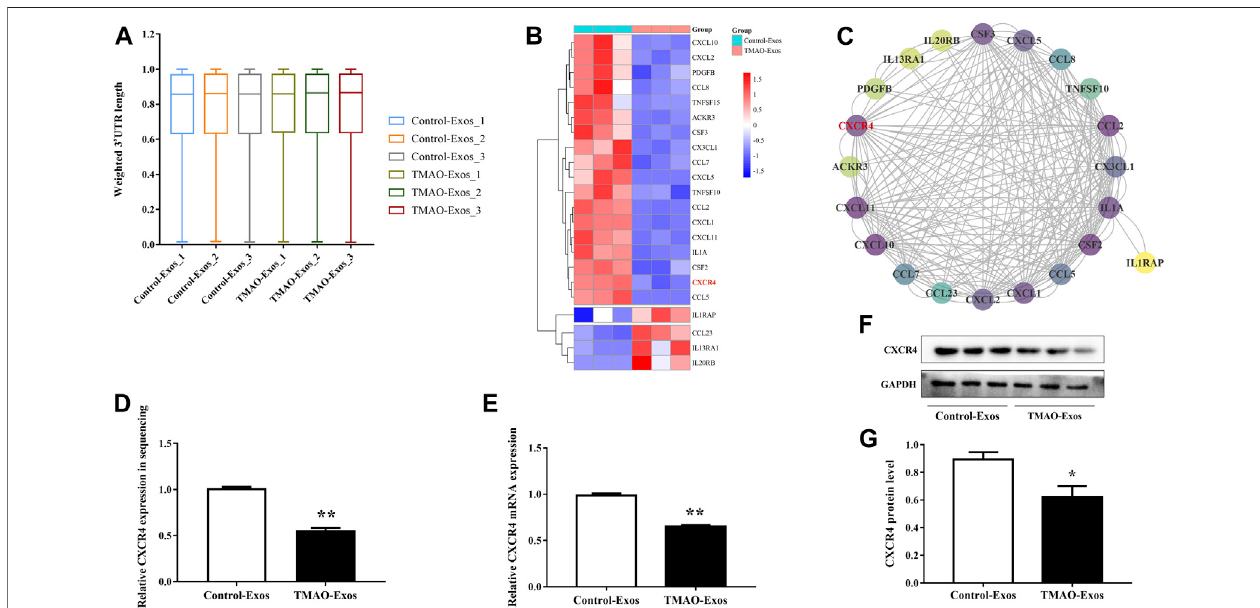
FIGURE 2 | TMAO-ExosreducedC-X-Cmotifchemokinereceptor4(CXCR4)expressionindependentlyofalternativesplicing. (A) Thetandem3 ′ -UTRlengthsofgenesin HAECswerenotsigni fi cantlyregulatedbyExos. (B) Thegenesinthe “ cytokine – cytokinereceptorinteraction ” genesetwerevisualizedonaheatmap. (C) CXCR4wasidenti fi edas akeygeneaccordingtotherelativedarkshade,withadegreeof30.Eachnoderepresentsagene,andthelinesbetweennodesillustrateinteractionsbetweengenes.Thecolorof the nodes represents the degree of gene interaction. (D − G) The levels of CXCR4 in sequencing were further validated at the mRNA and protein levels. All data were expressed as mean ± SEM. n = 3, independent t -test was performed for comparisons; ** p < 0.01, * p < 0.05 versus Control-Exos.